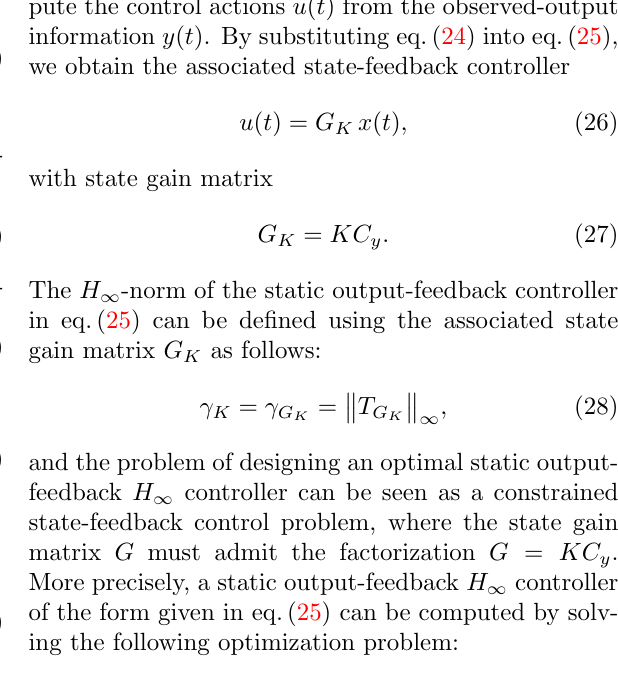
Figure 1: Linear matrix inequality for the static output-feedback H ∞ controller design with an asymptotically stable closed-loop matrix A and an optimal H ∞